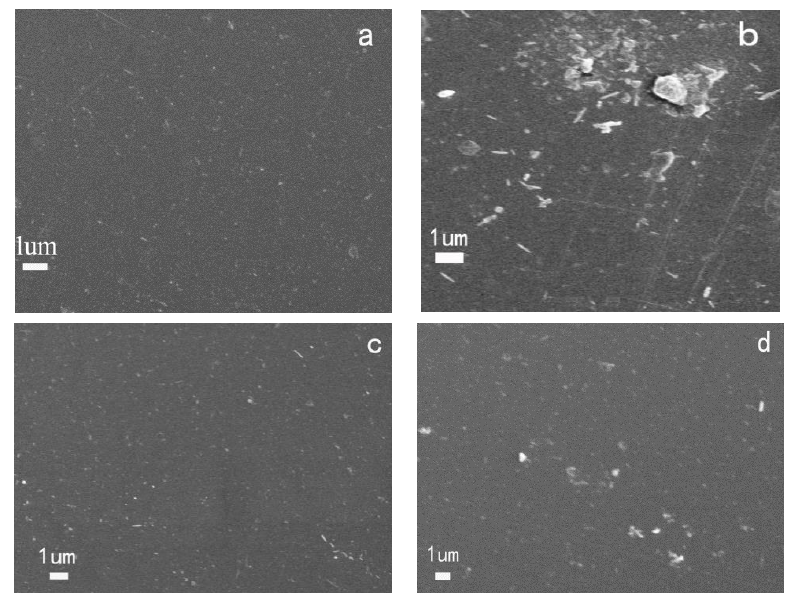
Figure 6. SEM images of ( a ) PMMA-TH-1%, ( b ) PMMA-H-3%, ( c ) PMMA-TH-3%, and ( d ) PMMA- TH-5%.